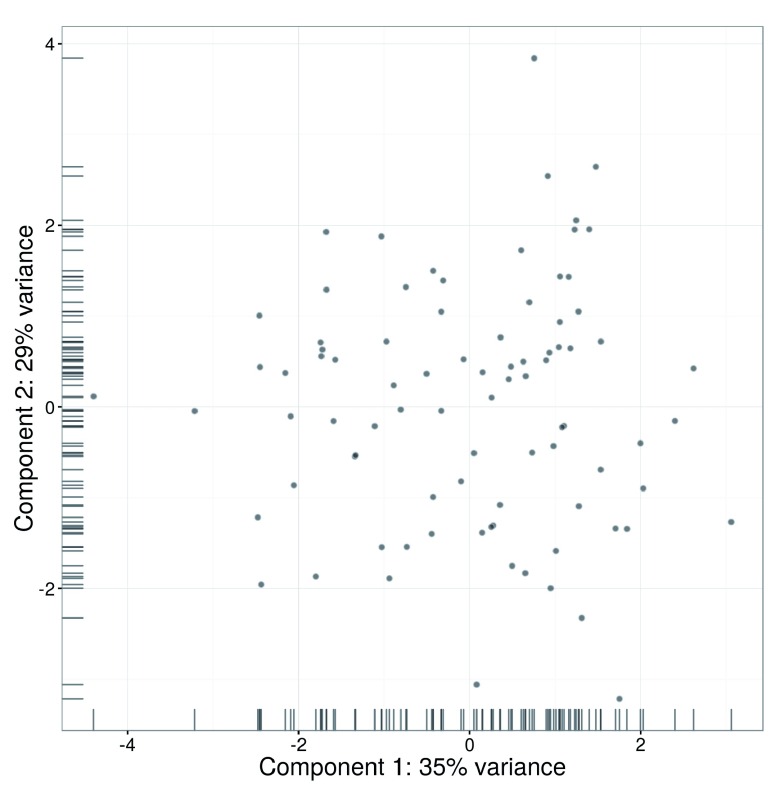
PCA plot for cells in the HSC dataset, constructed using quality metrics.The first and second components are shown on each axis, along with the percentage of total variance explained by each component. Bars represent the coordinates of the cells on each axis.